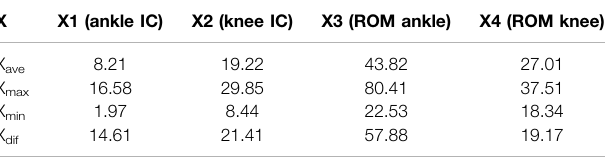
TABLE 1 | The average value (X ave ), maximum value (X max ), minimum value (X min ) and the difference between the maximum and minimum values (X dif ) of predictive variables